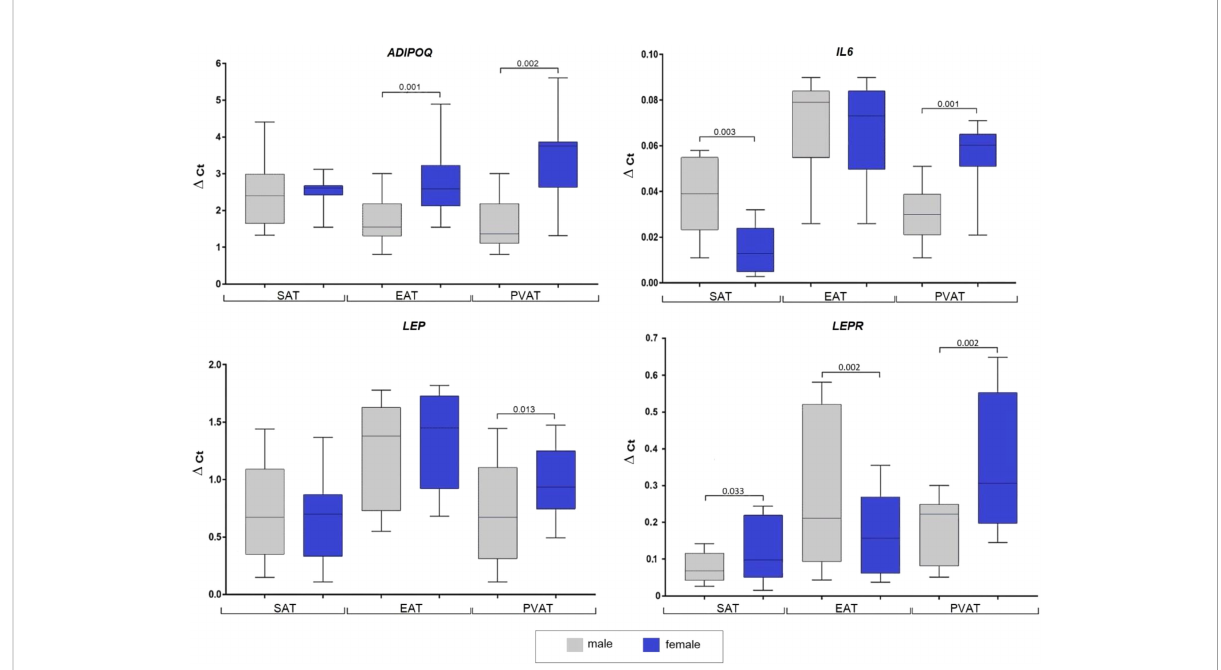
FIGURE 1 Adipocytokine genes expression in the subcutaneous, epicardial, and perivascular adipocytes based on the sex of patients with coronary artery disease. Data are presented in Me (Q1; Q3). SAT, subcutaneous adipose tissue; EAT, epicardial adipose tissue; PVAT, perivascular adipose tissue; p, level of statistical signi fi cance; sOB-R, soluble leptin receptor; IL6, interleukin